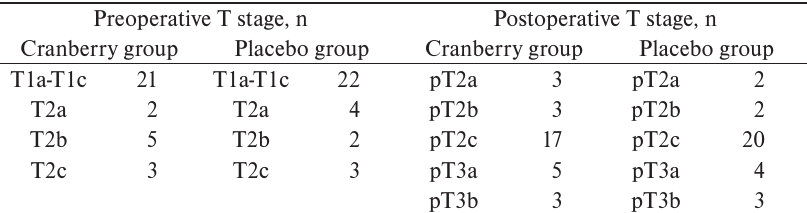
Table 2. Histopathological preoperative and postoperative T stage.